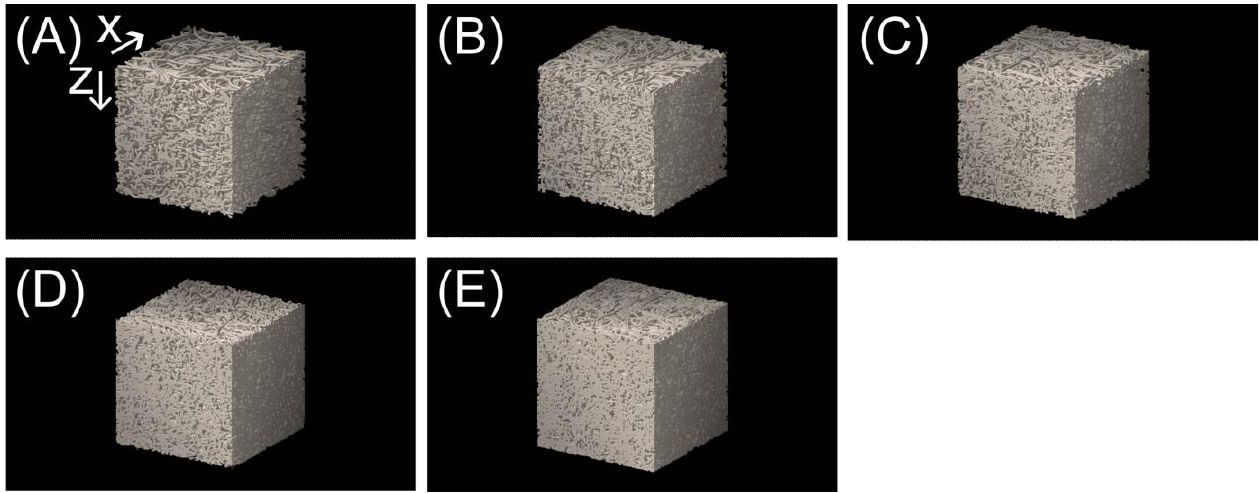
Figure 5. X-ray computed tomography images. The thickness of each image (in the z-direction) is 0.500 mm and the lengths in the x- and y-directions are 0.503 mm. ( A ) 8-ply laminated product, ( B ) 10-ply laminated product, ( C ) 12-ply laminated product, ( D ) 14-ply laminated product, and ( E ) 16-ply laminated product.